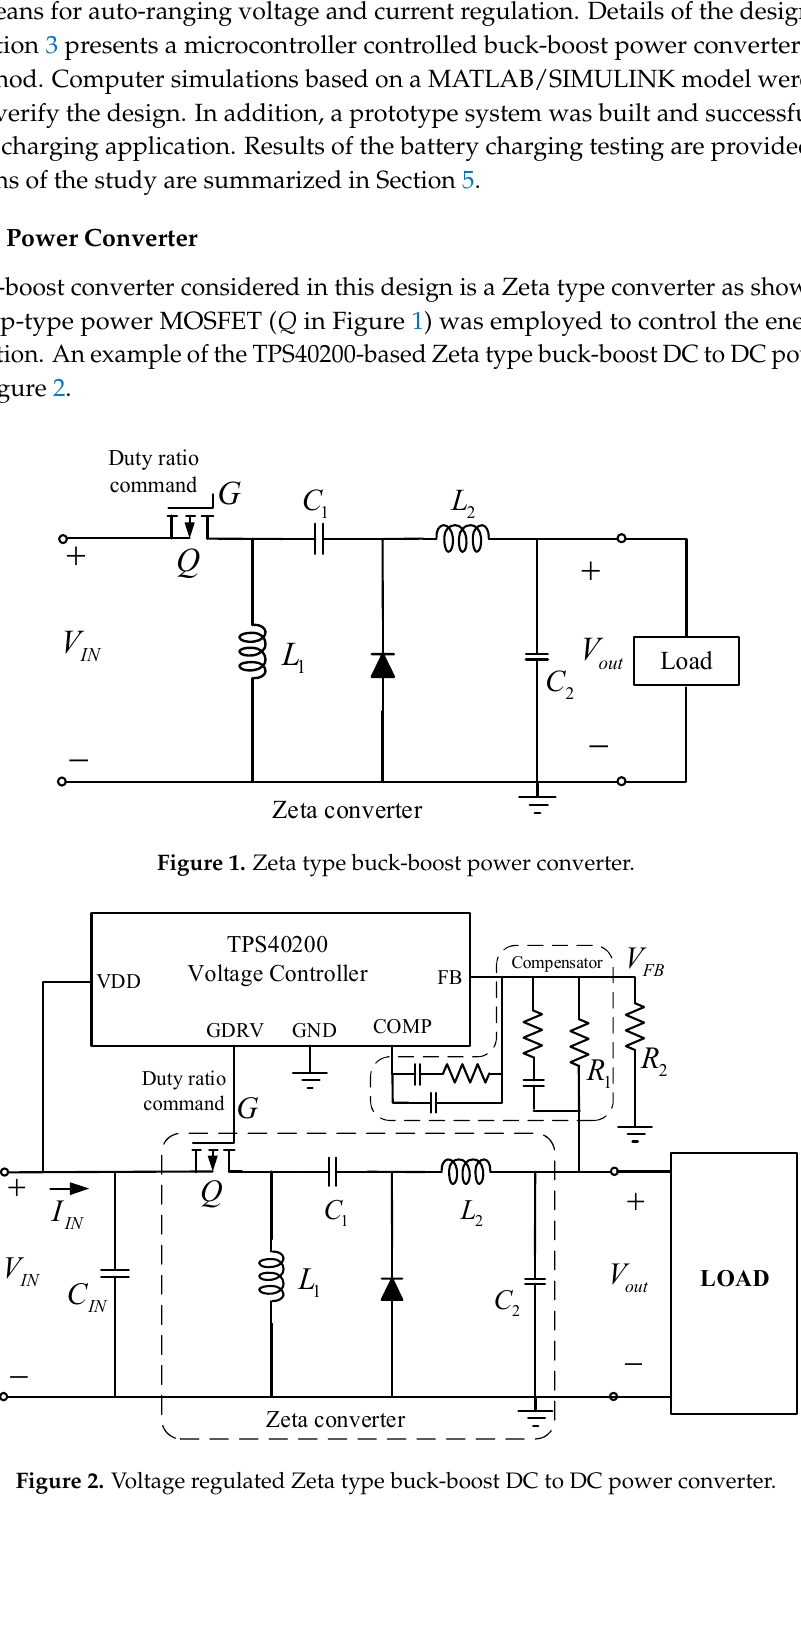
is regulated at 0.7 V by a